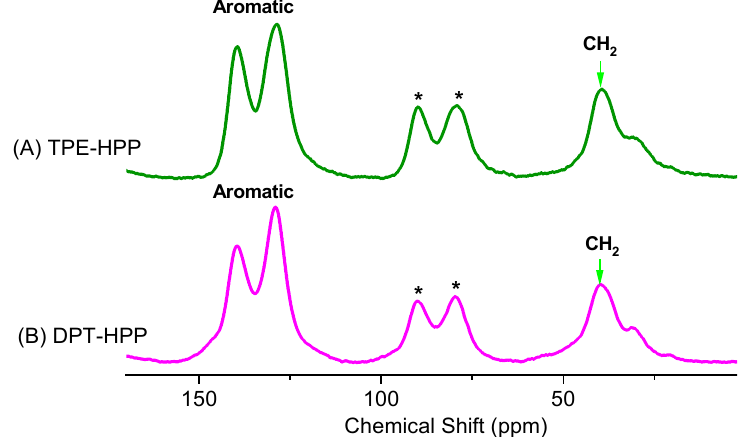
Figure 3. Solid-state 13 C CP / MAS NMR spectra of ( A ) TPE-HPP and ( B ) DPT-HPP where * is the side band of solid state NMR.